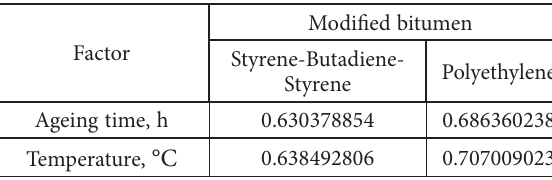
Table 5. The grey relational degree of factors on the